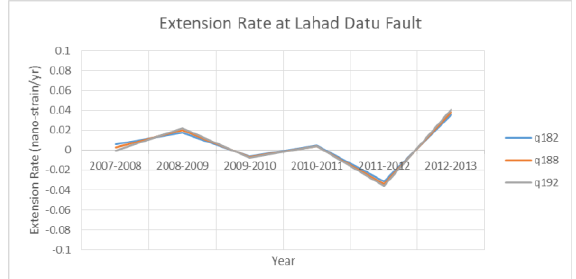
Figure 22. Extension rate changes on Lahad Datu Fault’s Quasi Network points (q182, q188 and q192) from 2007 to 2013.